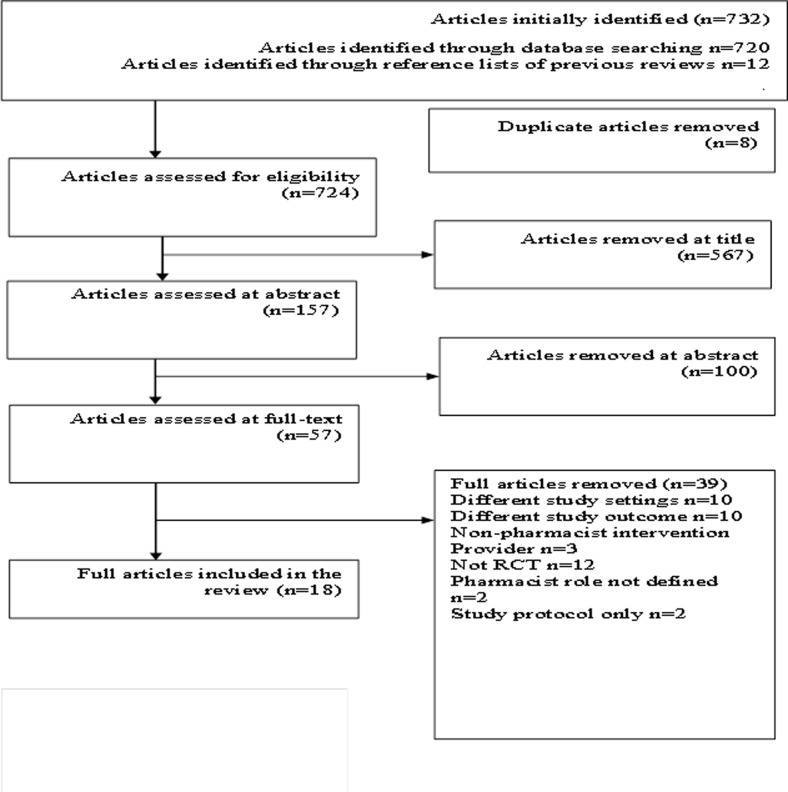
Prisma flow diagram representing the selection process of articles included in the review.